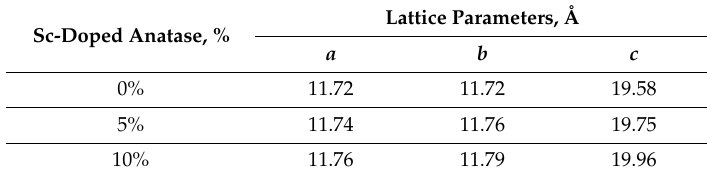
Table A2. Lattice parameters of pure and Sc-doped TiO 2.